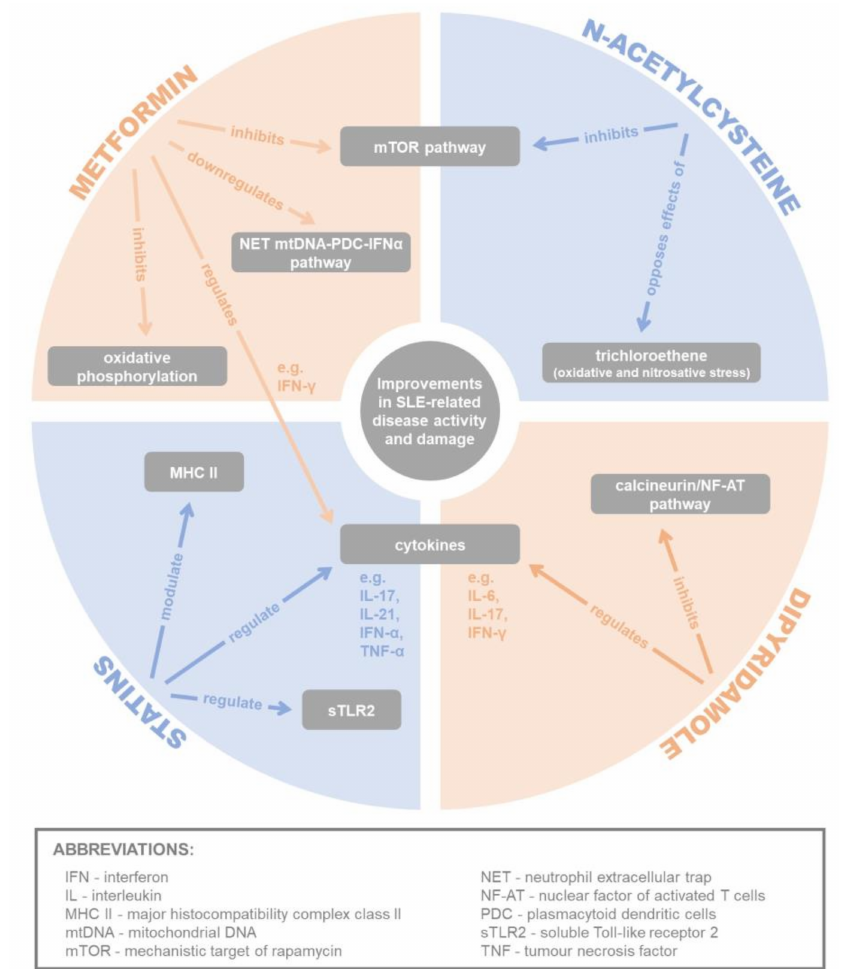
Figure 2. Summary of potential mechanisms of metformin, dipyridamole, N-acetylcysteine and statins in alleviating systemic lupus erythematosus (SLE)-related disease activity and damage. Table 1. Summary of studies addressing the potential mechanisms of metformin,